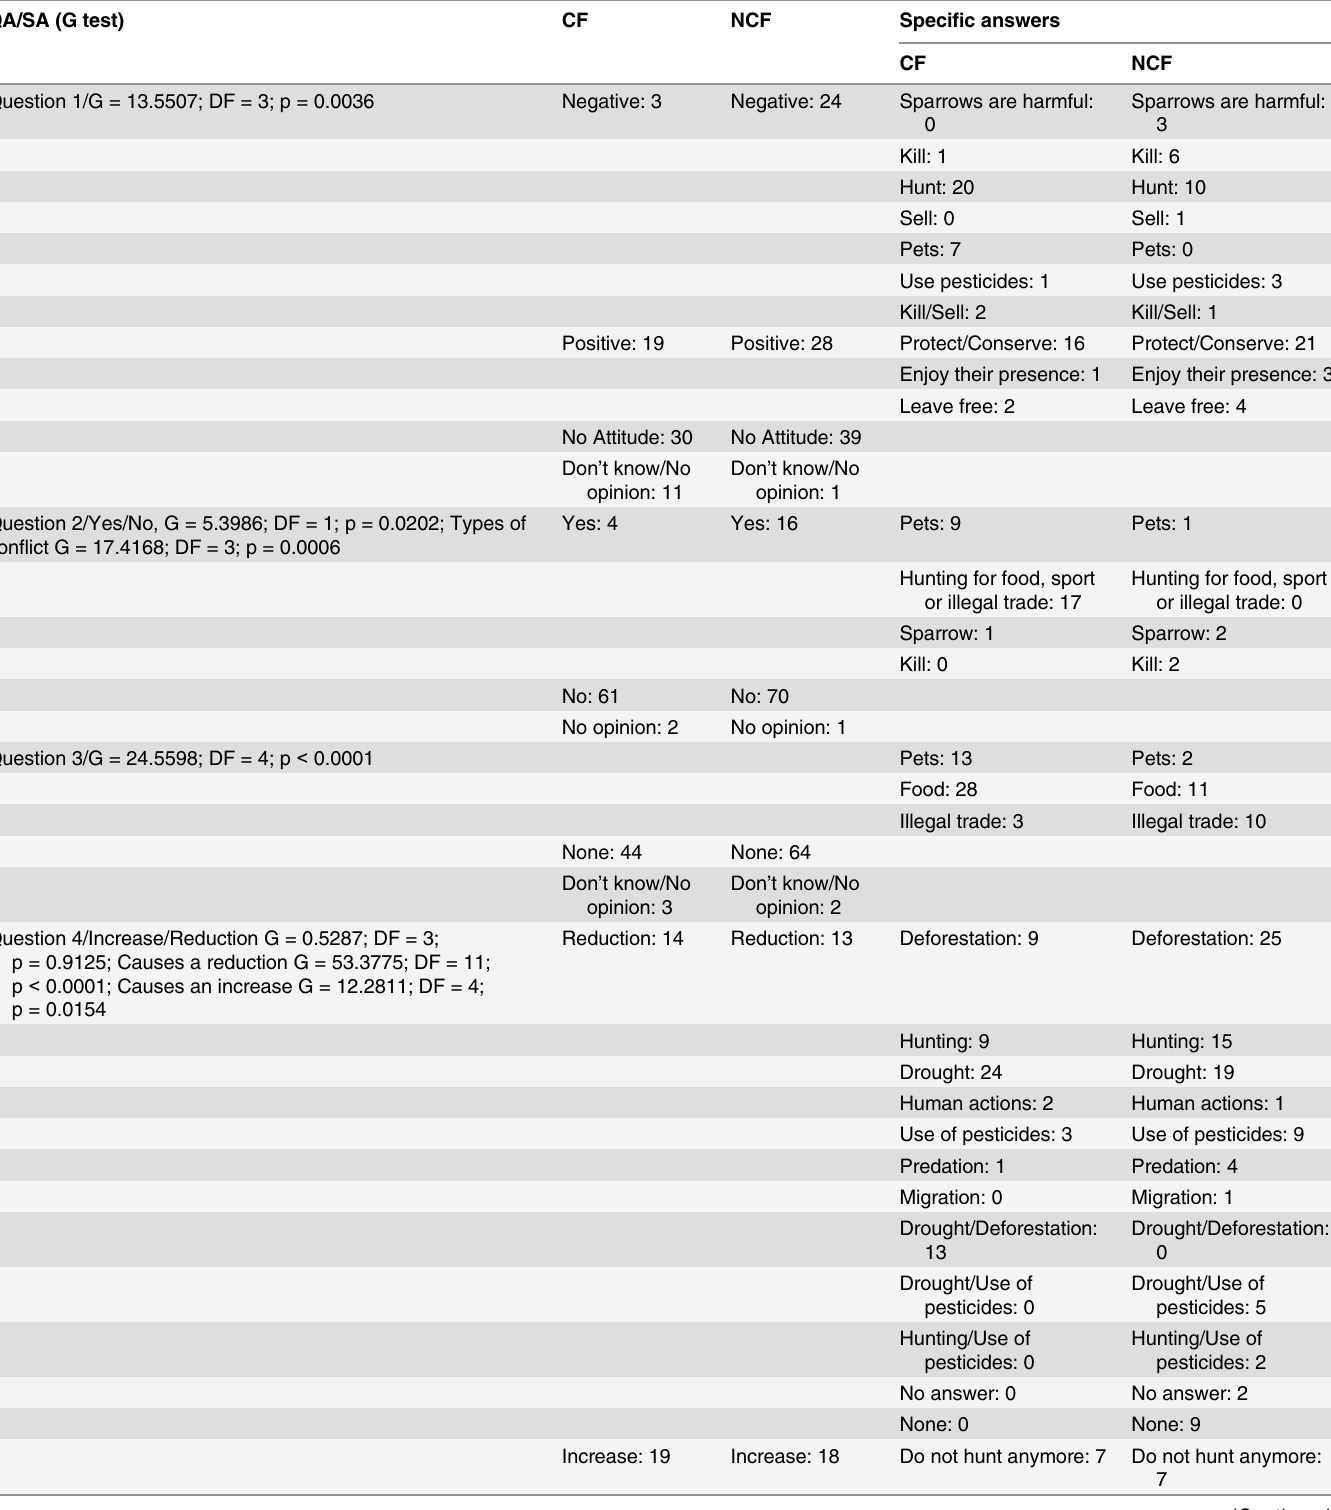
Table 2. Analysis of the questions presented to the conventional and non-conventional farmers to assess their attitudes, conflicts, uses, percep- tions of benefits/harm and perceptions of increases/reductions in numbers with regard to local bird species. QA/SA (G test) CF NCF Speci fi c answers CF